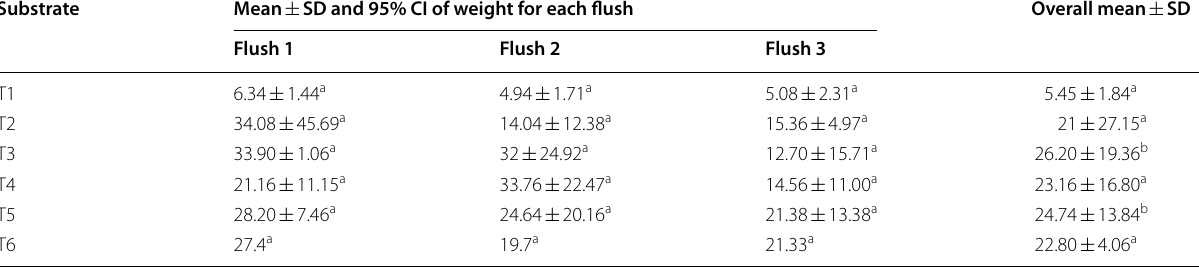
ª The mean difference is significantly at 0.05 level